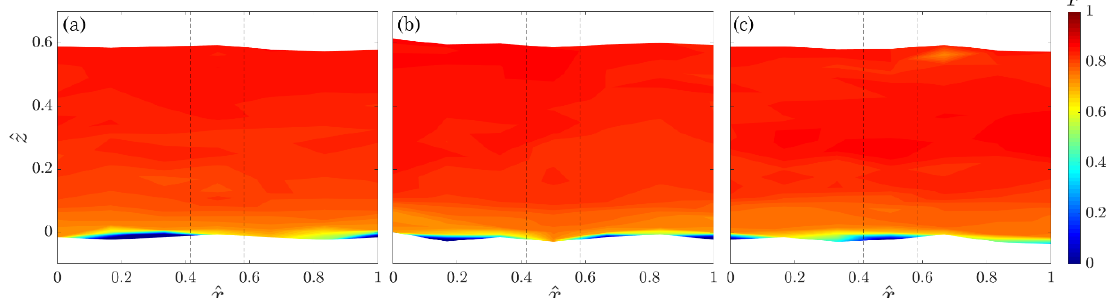
Figure 11. Contours of the anisotropic invariant function F in the test section for ( a ) Run 1, ( b ) Run 2, and ( c ) Run 3. The black broken lines indicate the edge of the vegetation stem.